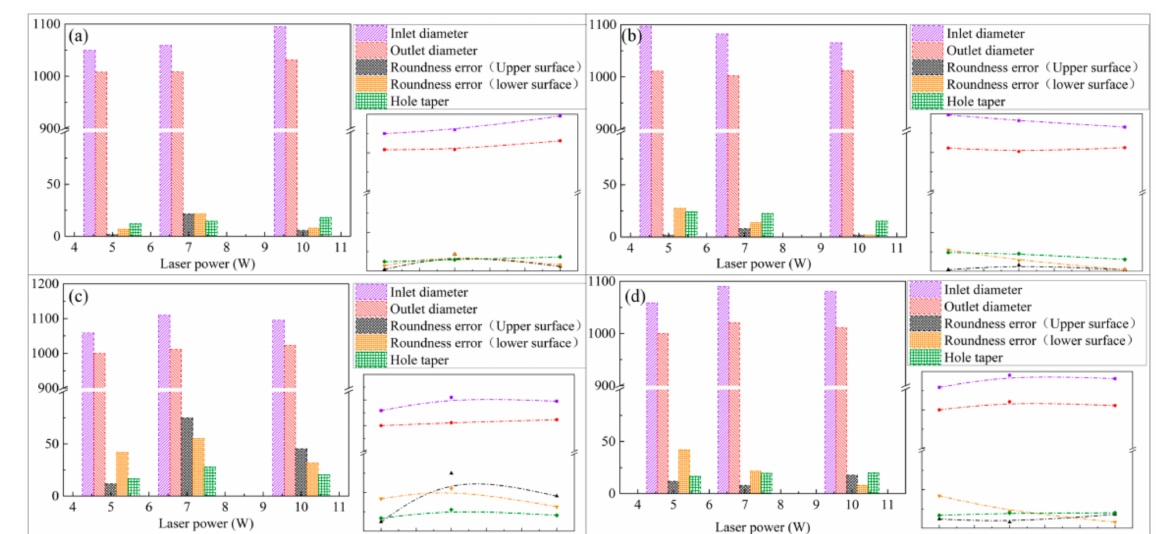
Figure 13. Hole appearance characteristics after helical drilling processing different metal materials: ( a ) aluminum alloy, ( b ) titanium alloy, ( c ) copper, ( d ) stainless steel.